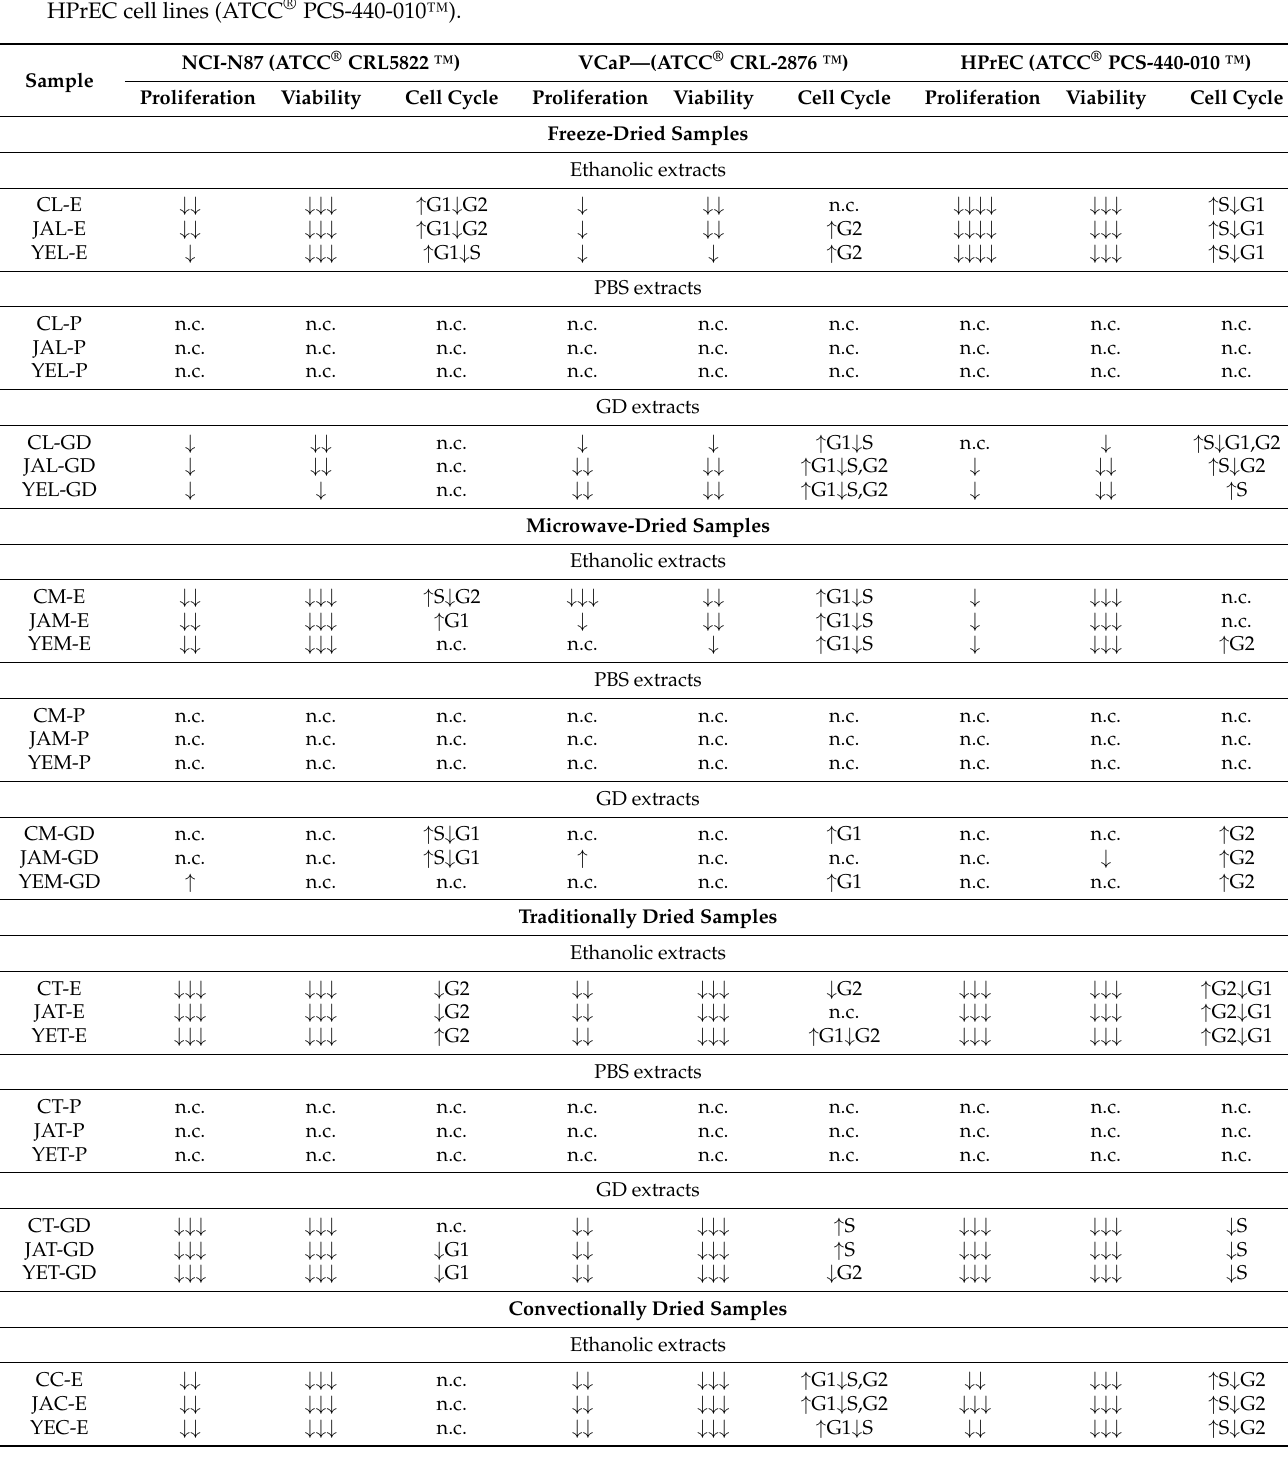
Table 4. In vitro effects of the highest concentration of the analyzed extracts after 72-h treatment on the cancer gastric epithelial NCI-N87 (ATCC ® CRL5822 ™), prostate cancer VCaP (ATCC ® CRL-2876 ™), and healthy prostate epithelial HPrEC cell lines (ATCC ®